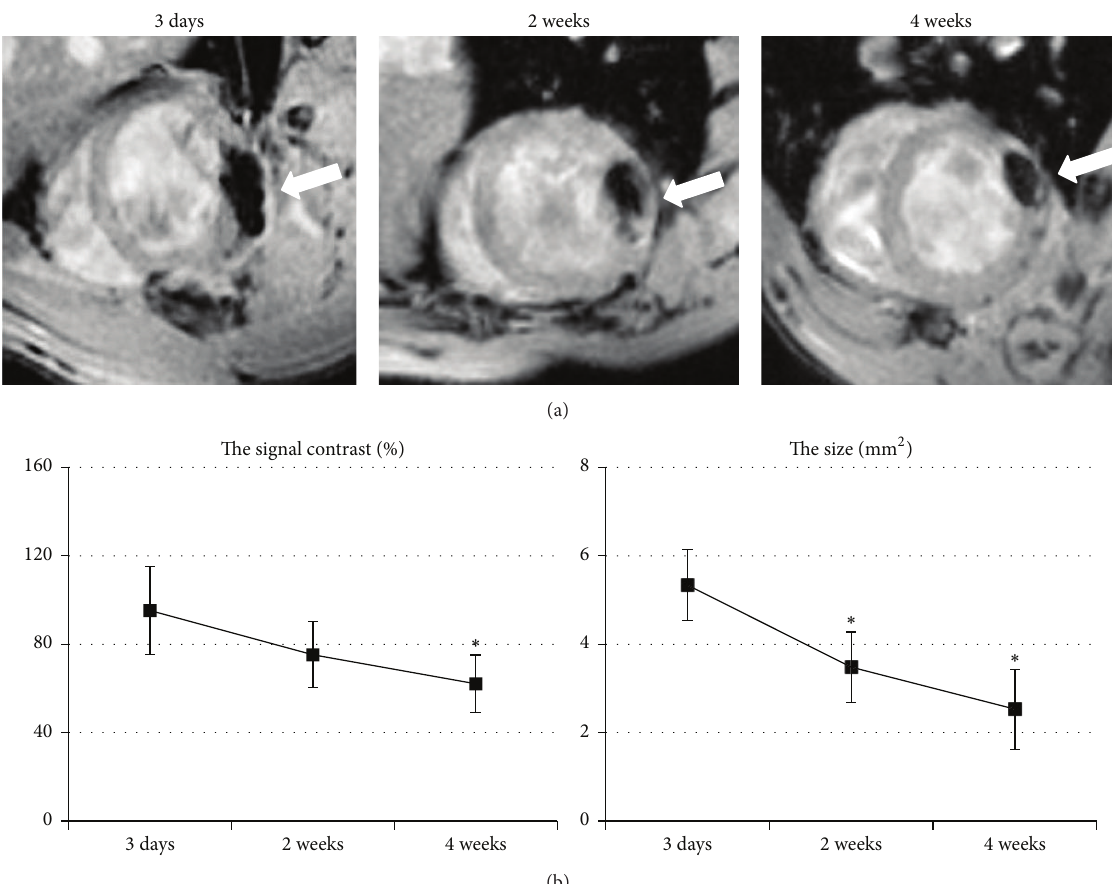
Figure 3: In vivo tracking of the MSCs after transplantation. (a) Persistent MR hypointensities caused by MPIOs were detected at all time points at the site of injection after transplantation (arrows). (b) As time progressed, the signal gradually weakened and the area decreased. 𝑁 = 9,9,8,8 at each time point ∗ 𝑝 < 0.05 versus 3